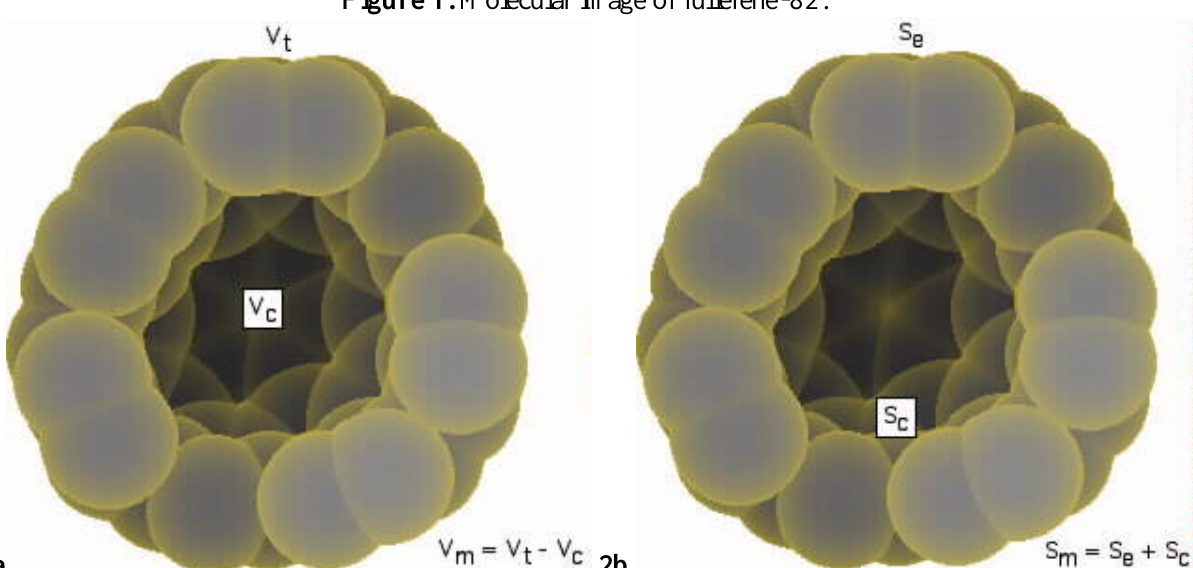
Figure 2. 2a. Molecular volumes and surfaces of fullerene-82: Molecular volume V